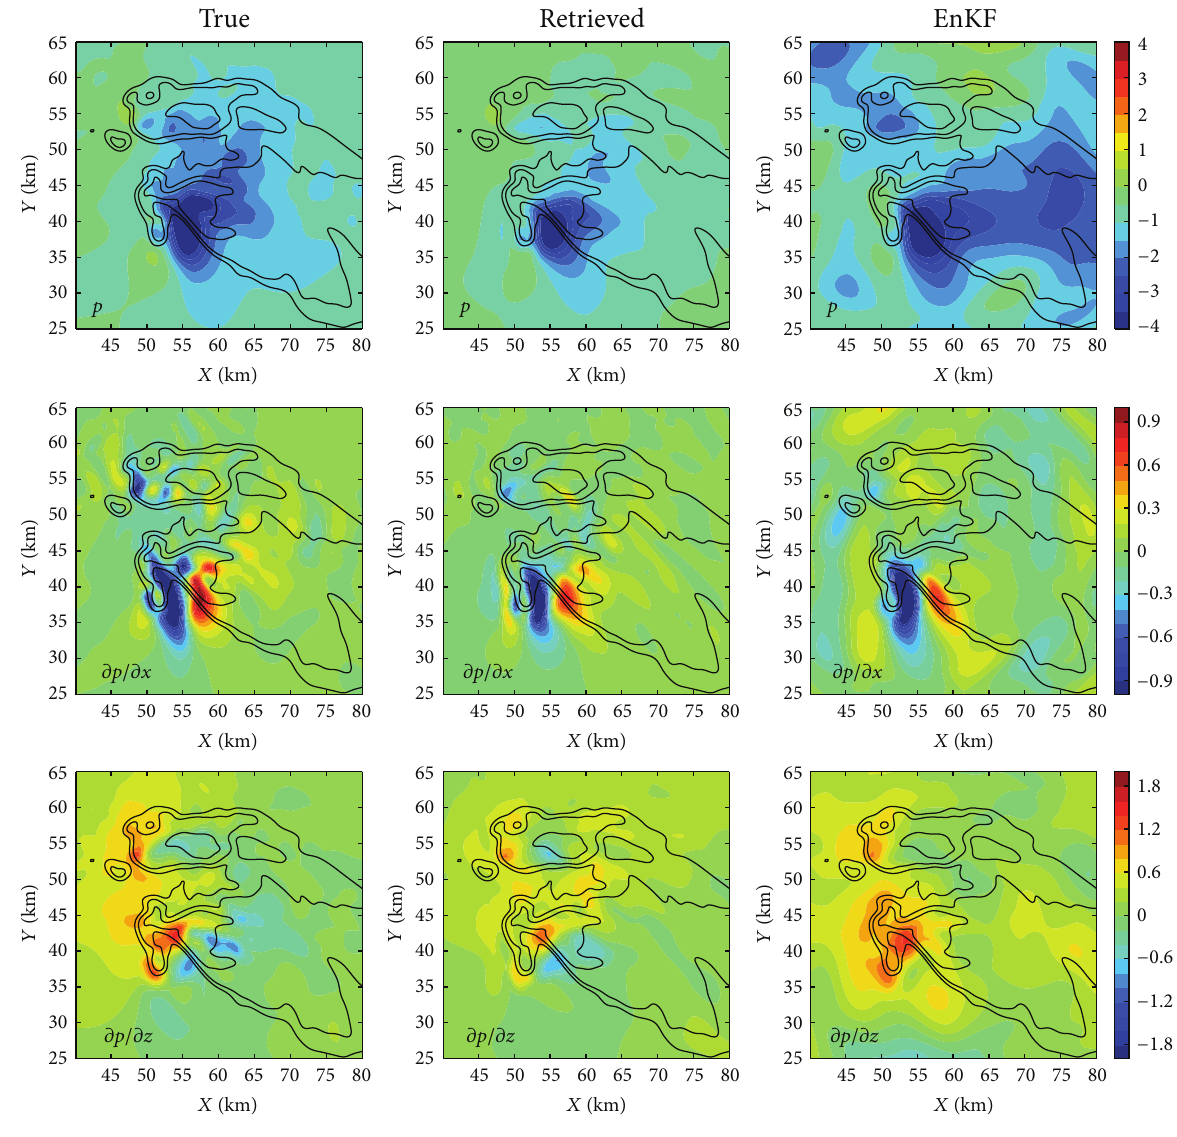
Figure 8: As in Figure 7 except for 𝑧 = 3.3